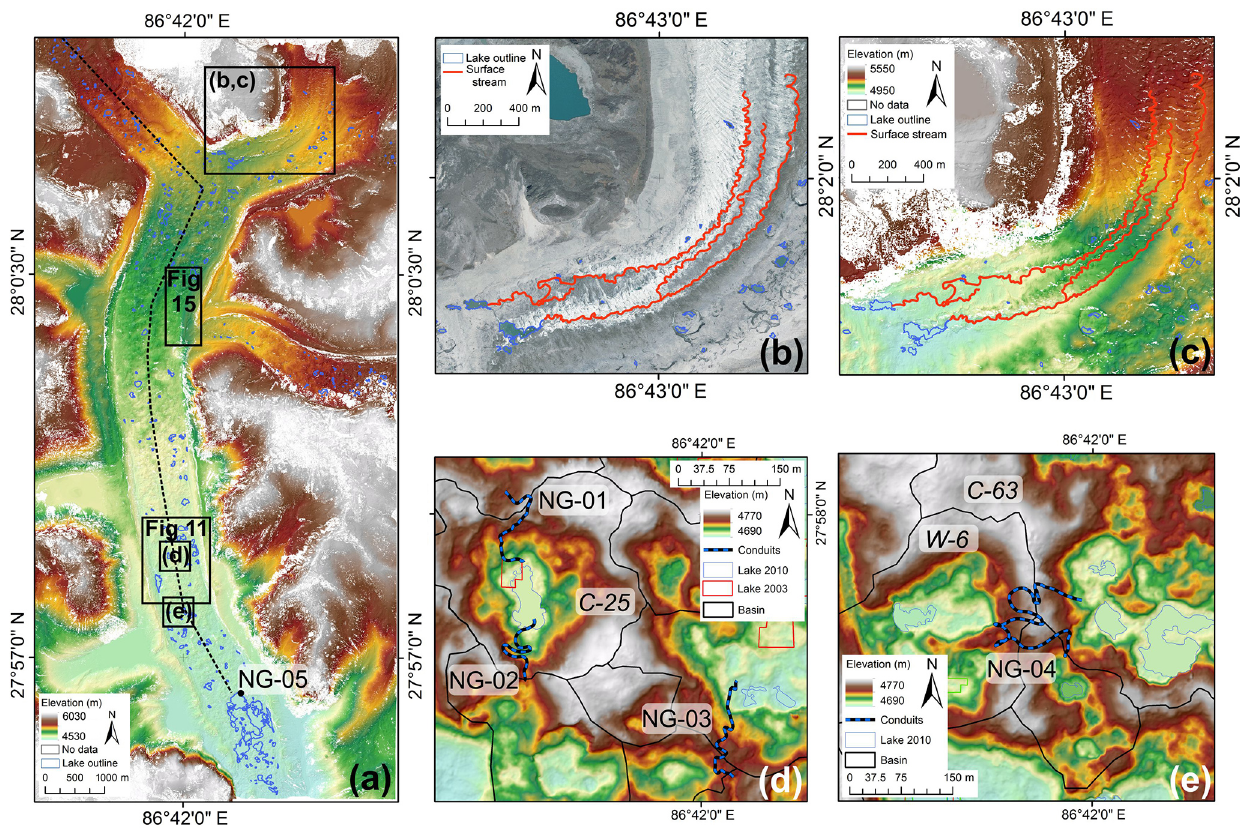
Figure 3. Examples of surface topography, supraglacial meltwater channels, and englacial conduit locations on Ngozumpa Glacier: (a) DEM of the lower ablation zone of the glacier, based on GeoEye-1 stereo imagery from June 2010, showing location of enlarged panels and englacial conduit NG-05; (b) supraglacial channels shown on the 2010 imagery; (c) the same area shown on the 2010 DEM; (d) hummocky debris-covered ice, showing the boundaries of closed surface basins and locations of englacial conduits NG-01 to NG-03 (considerable basin expansion occurred in the four ablation seasons between the conduit surveys (December 2005) and the date of the DEM (June 2010)); and (e) hummocky debris-covered ice and location of englacial conduit NG-04 (surveyed November 2009, 7 months before the date of the DEM). The dashed line in panel (a) shows the location of the long profile in Fig.